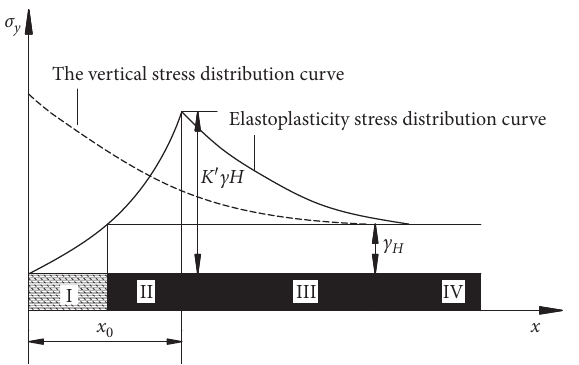
Figure 8: One side of the coal pillar is mined out.